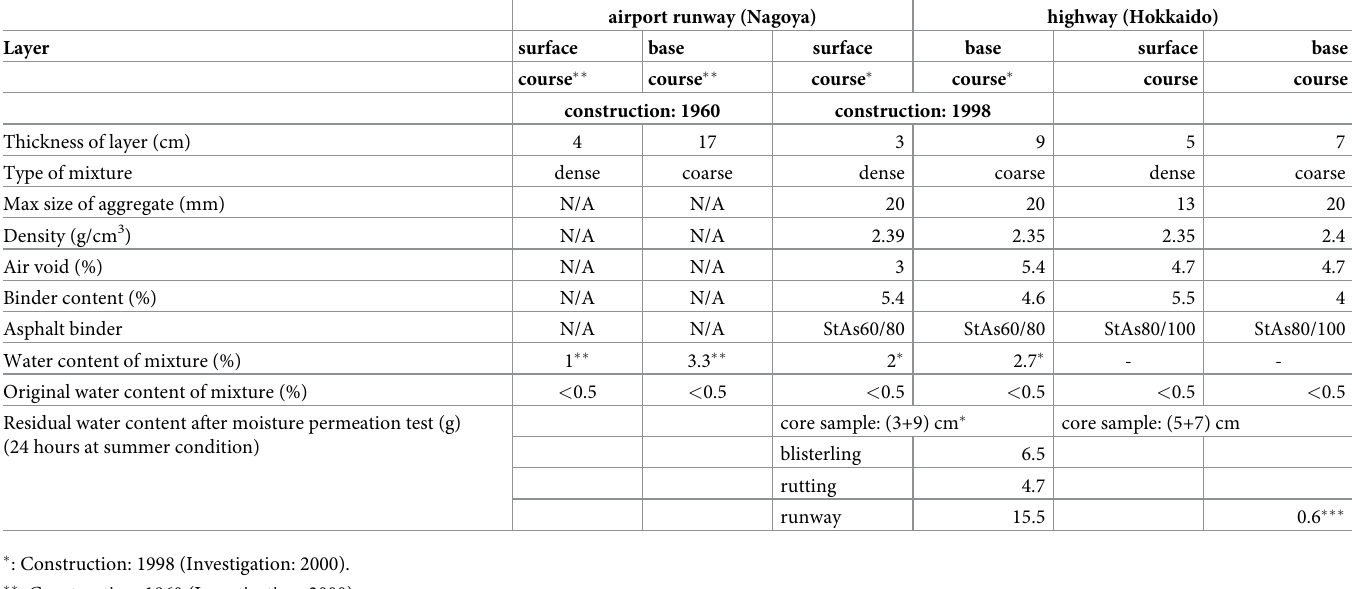
Table 4. Properties of asphalt mixtures in runway in